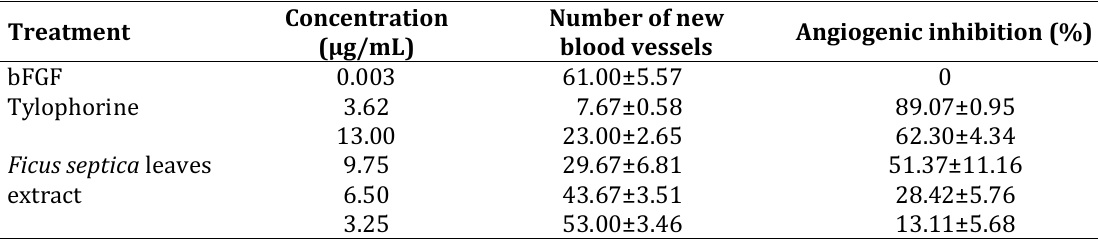
Table I. Angiogenic response and percent inhibition in CAM